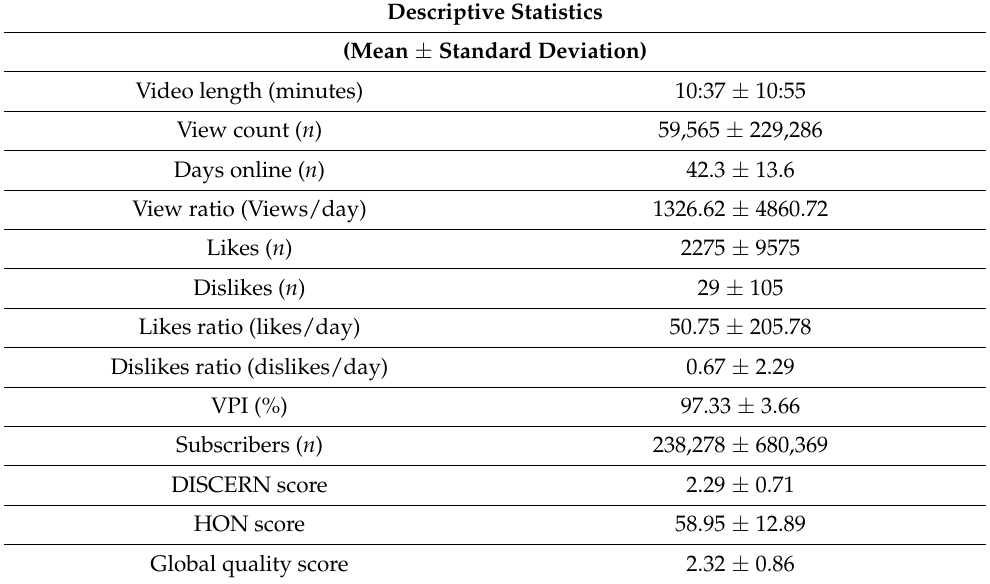
Table 1. Descriptive statistics of the